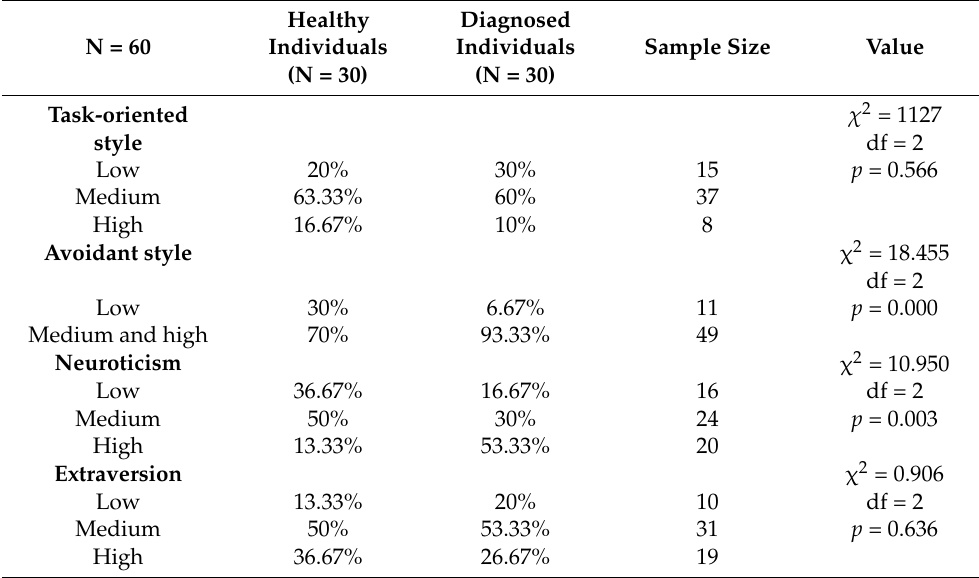
Table 3. The relationships between the variables: the frequency of using the coping style and personality, and the health condition of the